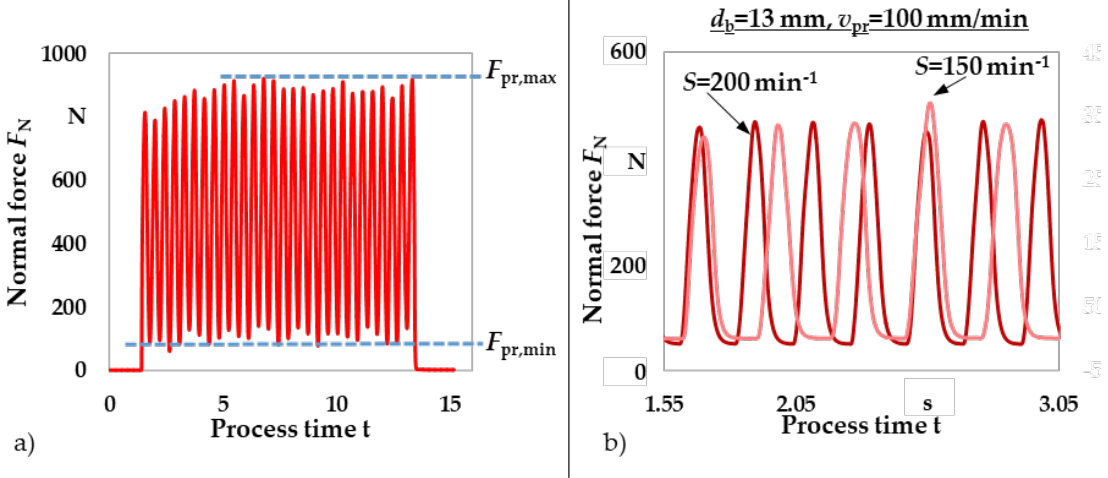
Figure 6. ( a ) Normal force (experiment ID: A7), ( b ) comparison of normal forces at varied spindle speed (zoomed extract of the force measurement of the experiments with the IDs T23 and T24).